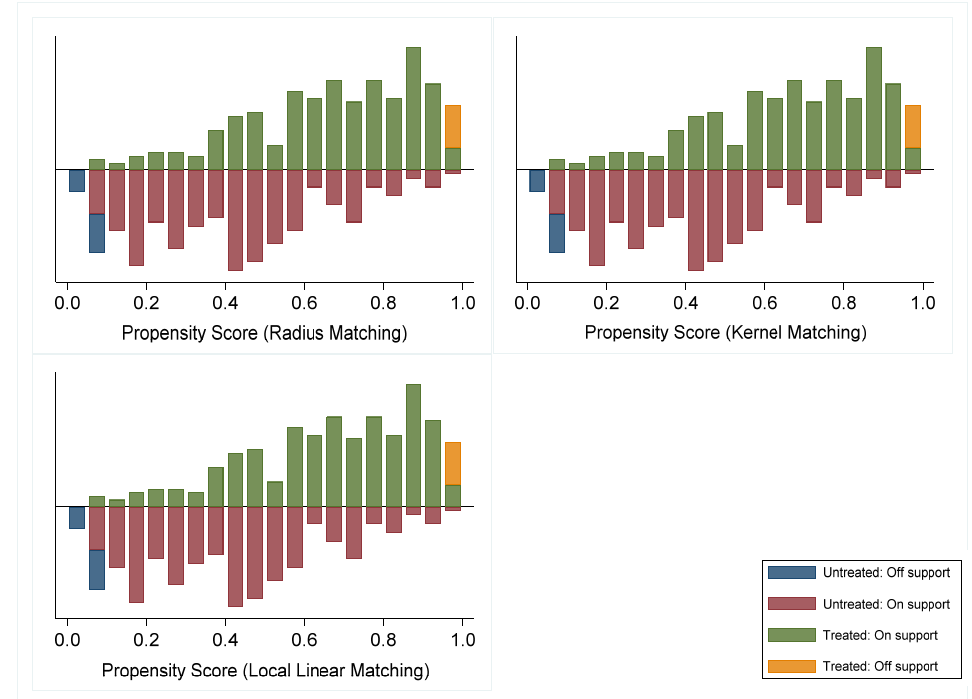
Figure 2. Common support areas for propensity scores.